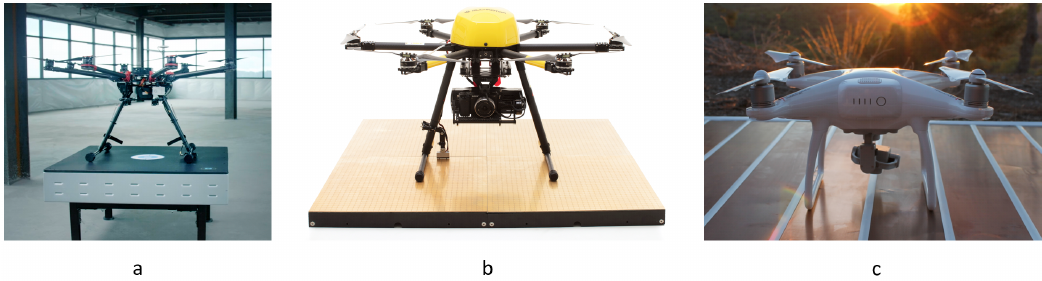
Figure 5. Examples of commercially available UAV charging platforms without positioning. ( a ), wireless charging pad by WiBotic (Seattle, WA, United States) [37]; ( b ), landing pad with alternating